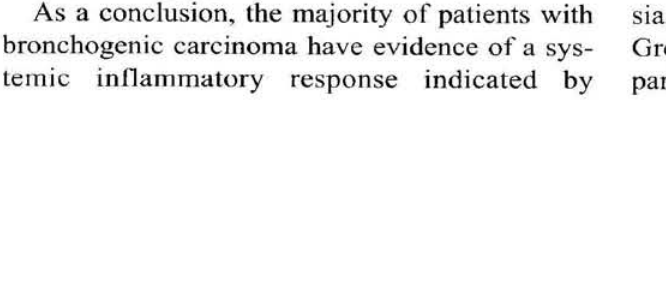
score: 9 ± 1 points vs. 7 ± 3